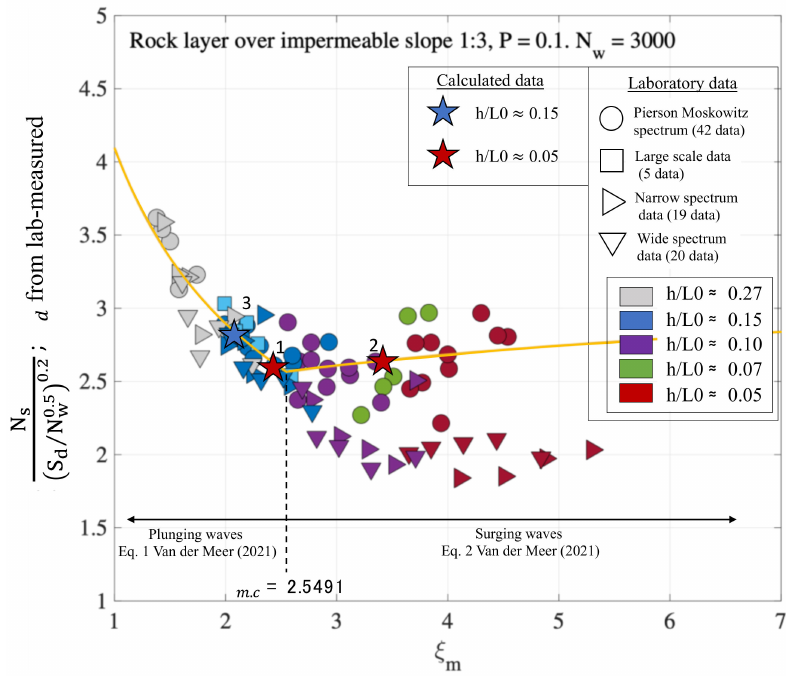
Figure 1. Application of the Van der Meer formula: breaker parameter—relative stability number graph. The symbols (circle, square, triangles) represent all the laboratory data obtained by Van der Meer [28] for an impermeable core and slope 1:3. By colors the values of relative water depth in deep water are included. The yellow curve is the formula of Van der Meer in plunging and surging wave breaker for a slope 1:3, P = 0.1 and N w = 3000. The stars-symbols are the data examples calculated with the formula for h / L 0 = 0.05 and 0.15. The laboratory data were taken from [28]. Table 1. Calculation of the nominal design diameter of a breakwater for a three sea states applying the formula of Van der Meer, and the corresponding data in laboratory with the same breaker parameter, N w = 3000 and h = 6